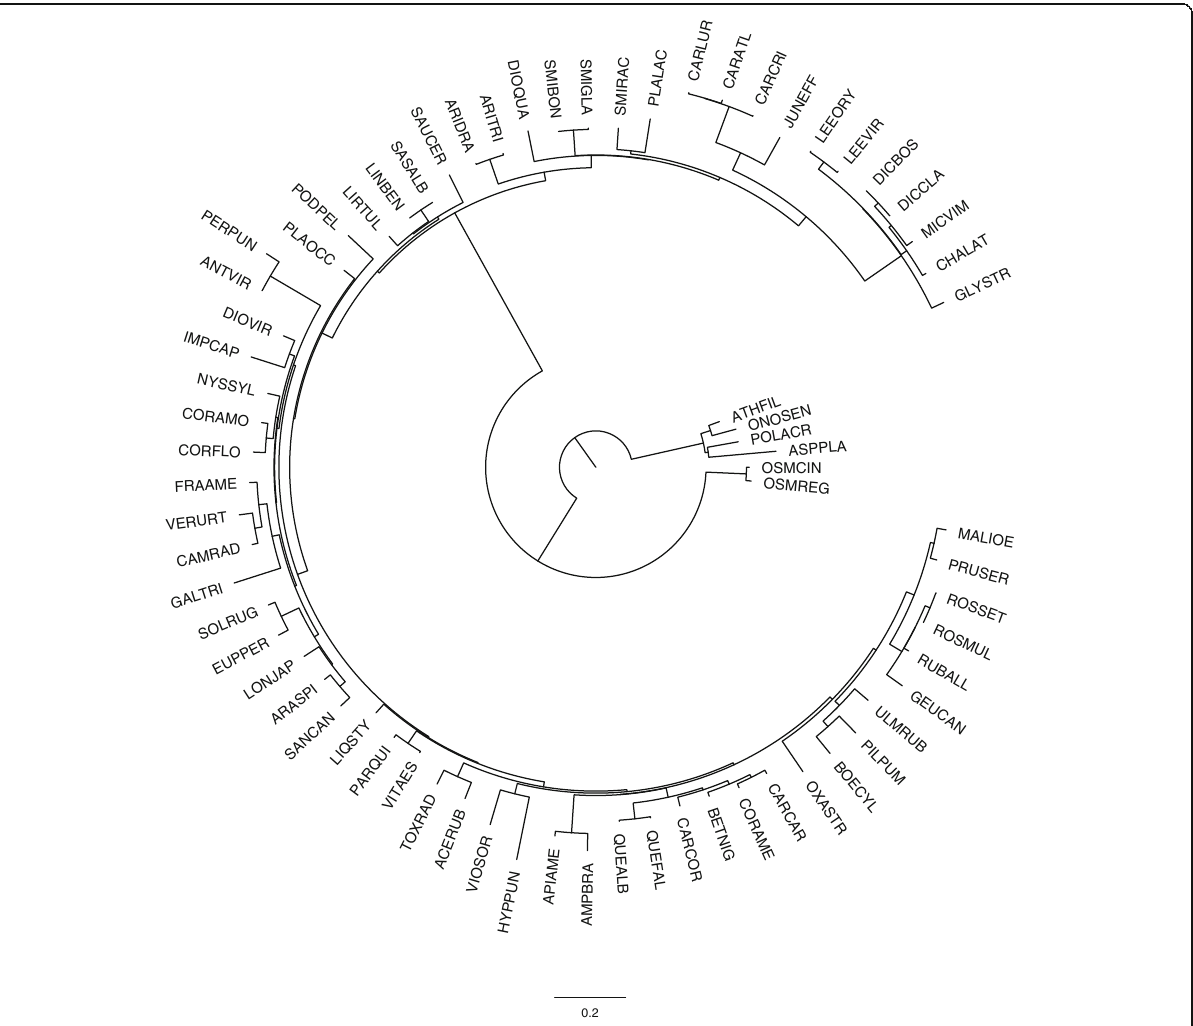
Fig. 1 Maximum likelihood phylogeny of species observed within 10 acid seep springs. The scale bar represents the substitution rate of nucleotides (at an individual locus) within concatenated rbcL and matK plastid regions over the specified distance. Species codes are available in Table S1. Monilophytes are positioned as the